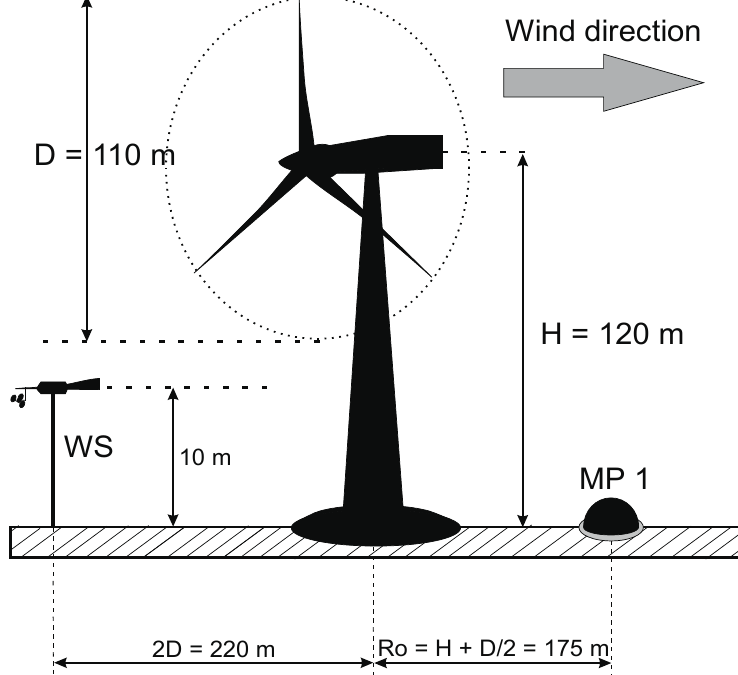
Figure 7. Location of the point of measurement (MP1) and WS in relation to investigated wind turbine on the basis of recommendations of IEC/EN 61400–11 standard, where: D—diameter of wind turbine rotor and H—height of turbine mast.